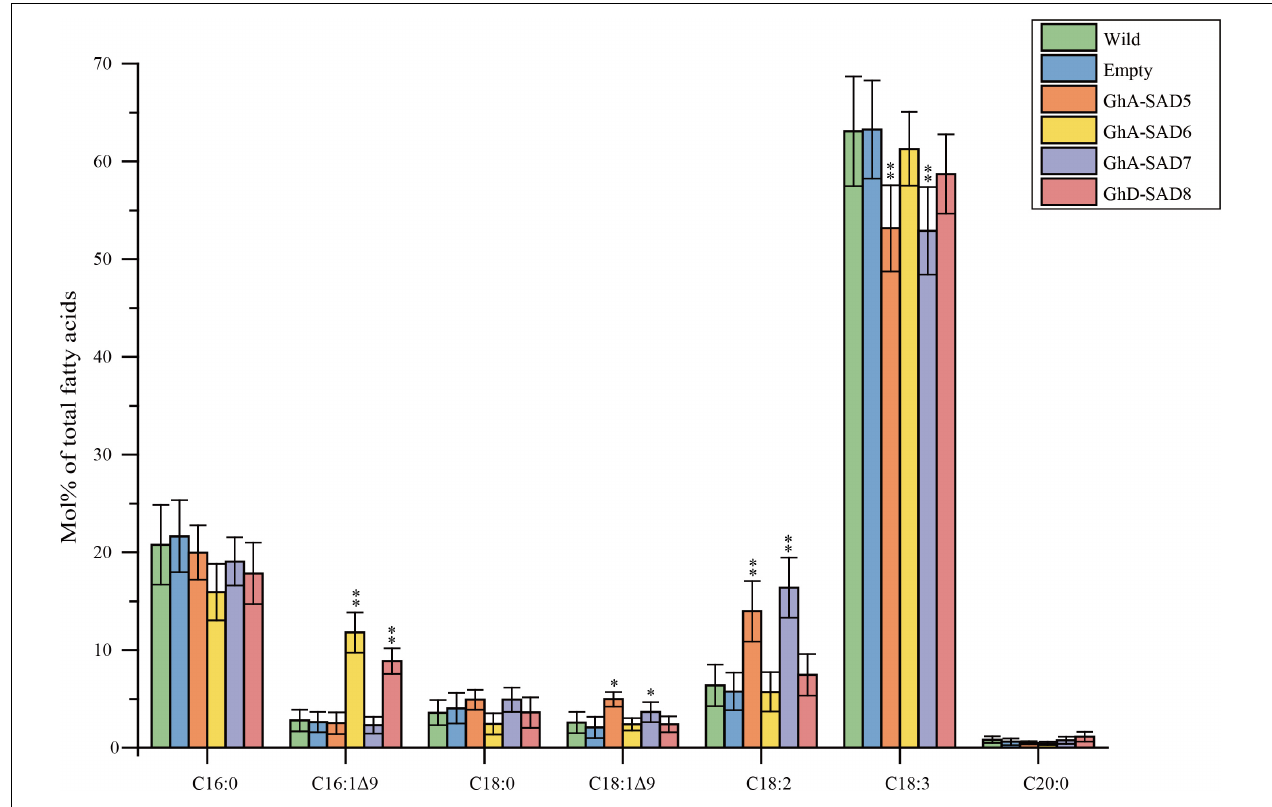
FIGURE 7 | Fatty acid composition in transgenic N. benthamiana leaves of expressing GhA-SAD5 , GhA-SAD6 , GhA-SAD7, and GhD-SAD8 , respectively. Fatty acids were analyzed by GC and the data are means of Mol% ± SE with six biological replicates. “ ∗ ” and “ ∗∗ ” represent statistically significant difference values from Wt (or empty) of P < 0.05 and P < 0.01 based on two-tailed Student’s t -tests, respectively. Empty vector of pCAMBIA1303 was used as negative control. Data are showed as mean ± SE ( n =